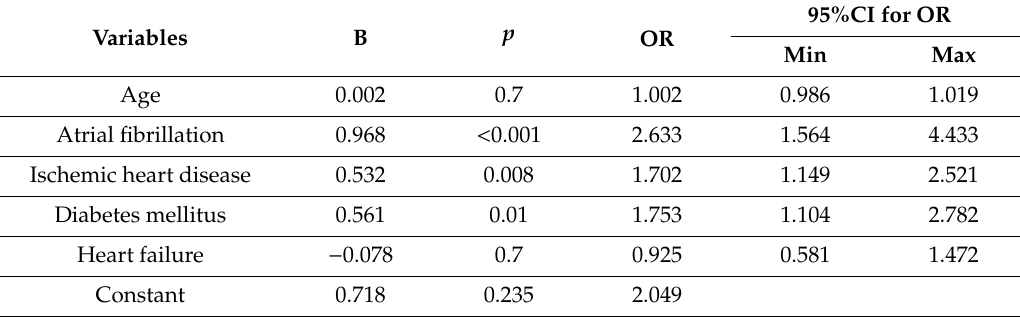
Table 3. Multivariate logistic regression for OAC preference.